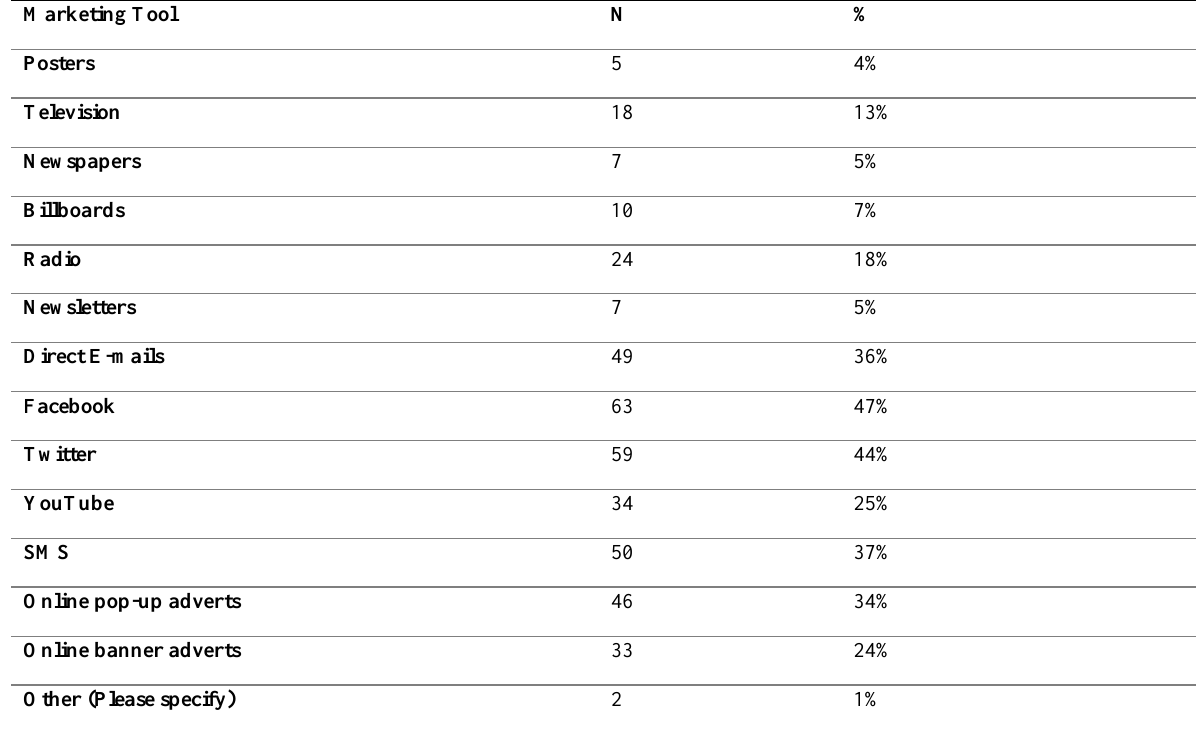
Table 2: Marketing communication media used as real-time marketing